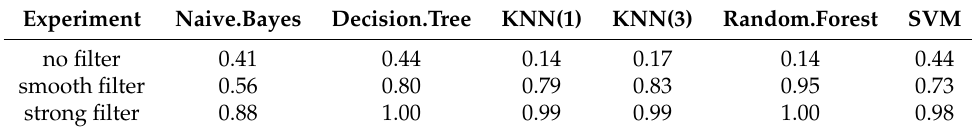
Table 3. 10-fold-crossvalidation accuracy on training dataset (dry+rain+storm). Experiment